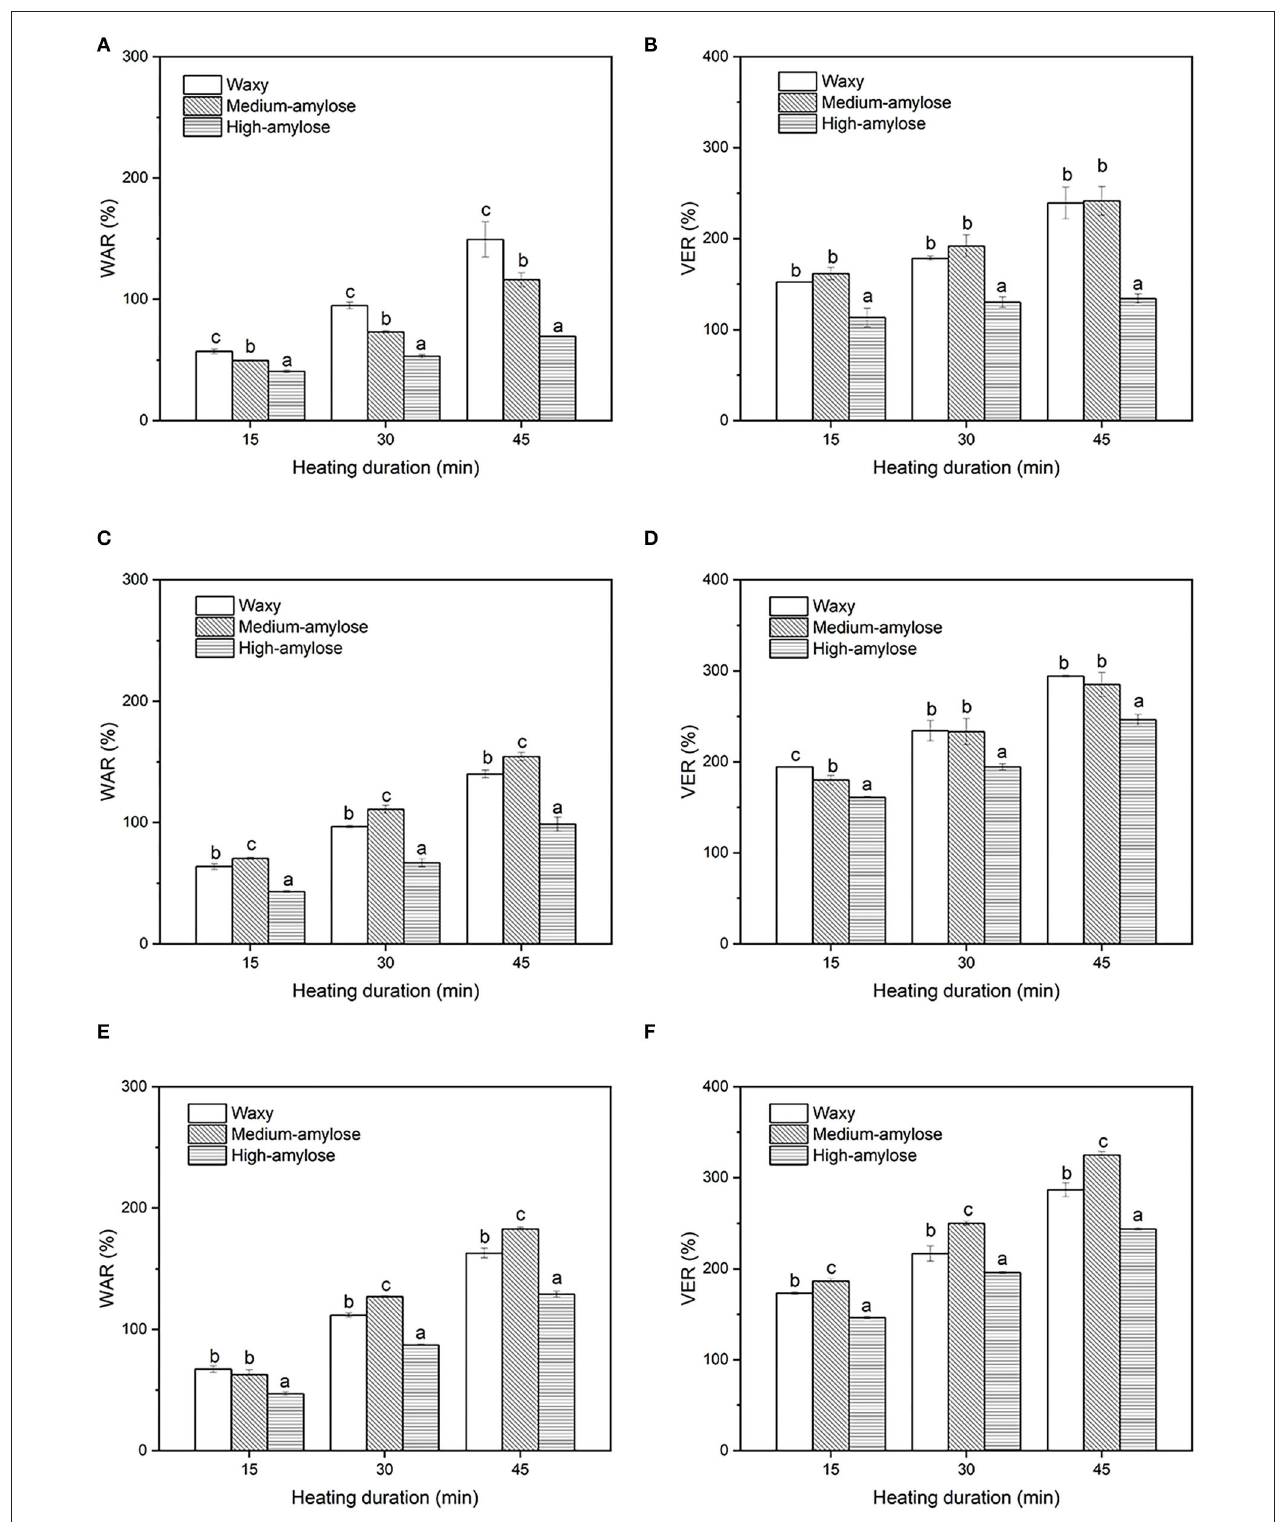
FIGURE 3 | Water absorption ratio (WAR) and volume expansion ratio (VER) of parboiled black rice heated in different temperatures of water. (A) WAR-80 ◦ C; (B) VER-80 ◦ C; (C) WAR-90 ◦ C; (D) VER-90 ◦ C; (E) WAR-100 ◦ C; (F) VER-100 ◦ C. For a specific heating duration in each subfigure, columns with the same letter were not significantly different (a =